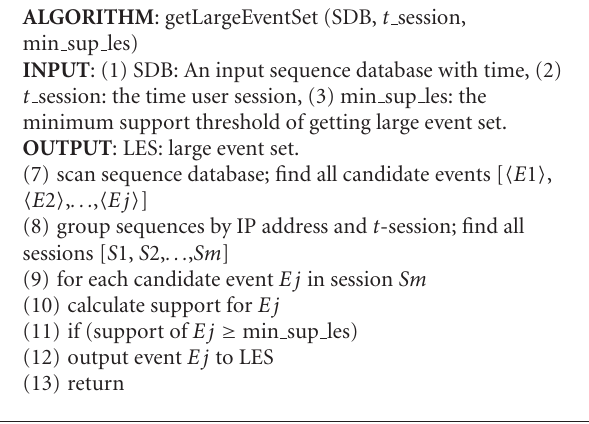
ALGORITHM : getLargeEventSet (SDB, t session,